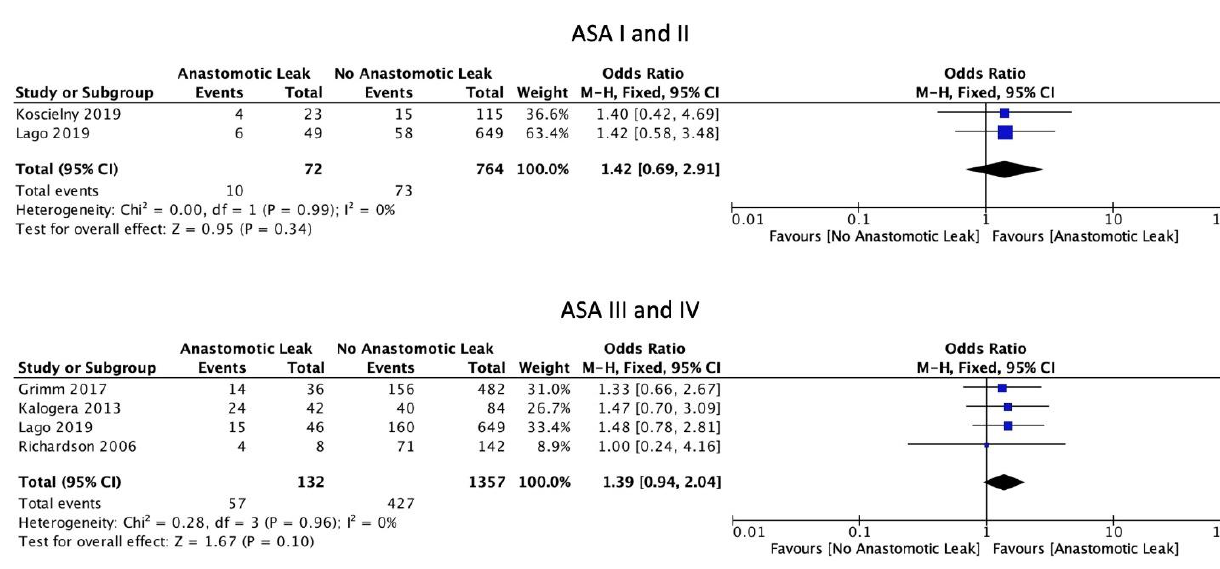
Figure 3. ASA scores.